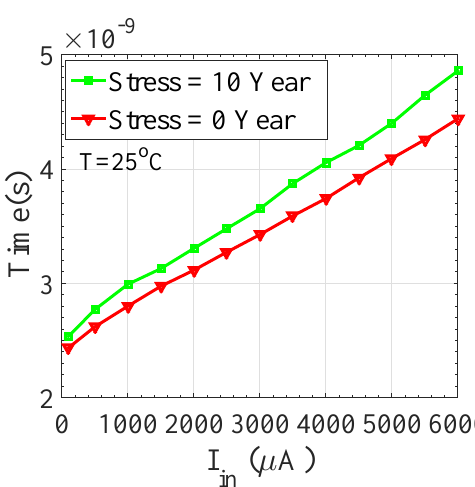
Figure 12. Negative bias temperature instability (NBTI)-induced voltage-to-time characteristic for the proposed design.